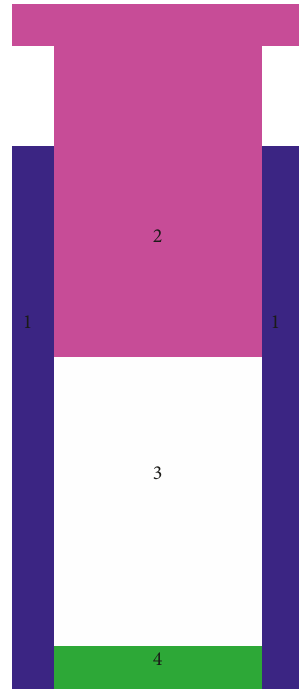
Figure 5: Mould of compacting samples. (1) Stainless steel barrel. (2) Stainless steel head. (3) Soil. (4) Heel